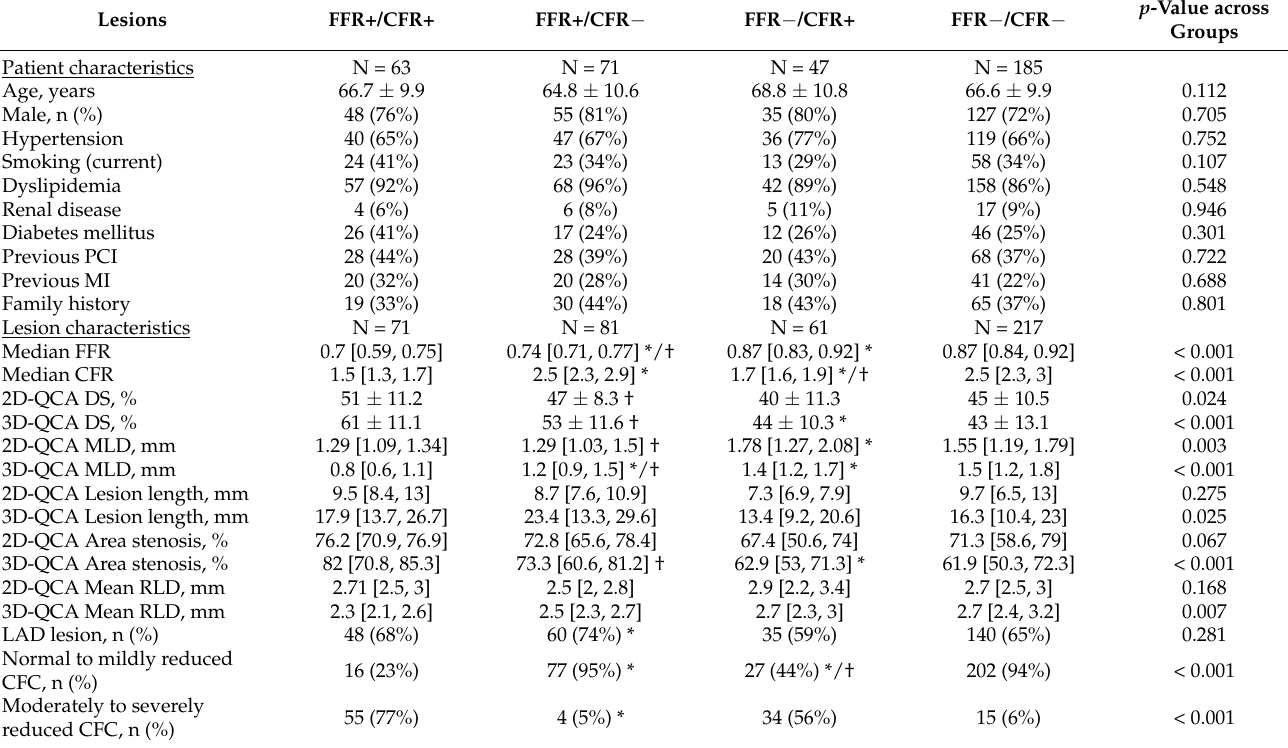
Table 3. Clinical and angiographic parameters in 430 intermediate coronary